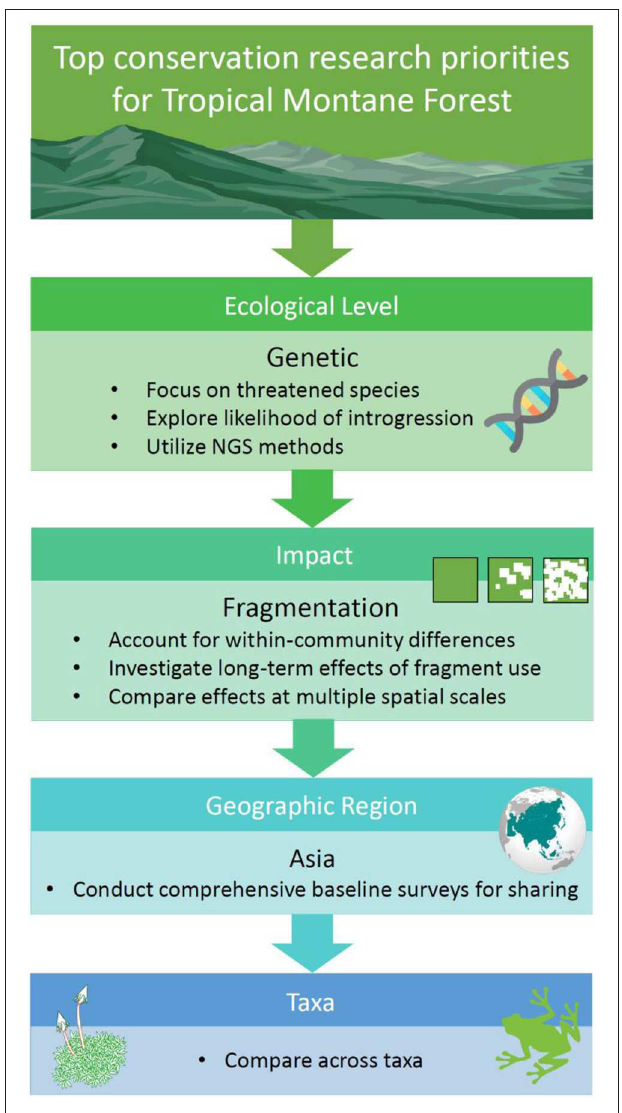
FIGURE 8 | Research priorities for conserving the world’s tropical montane forest ecosystems, indicated in order of importance.